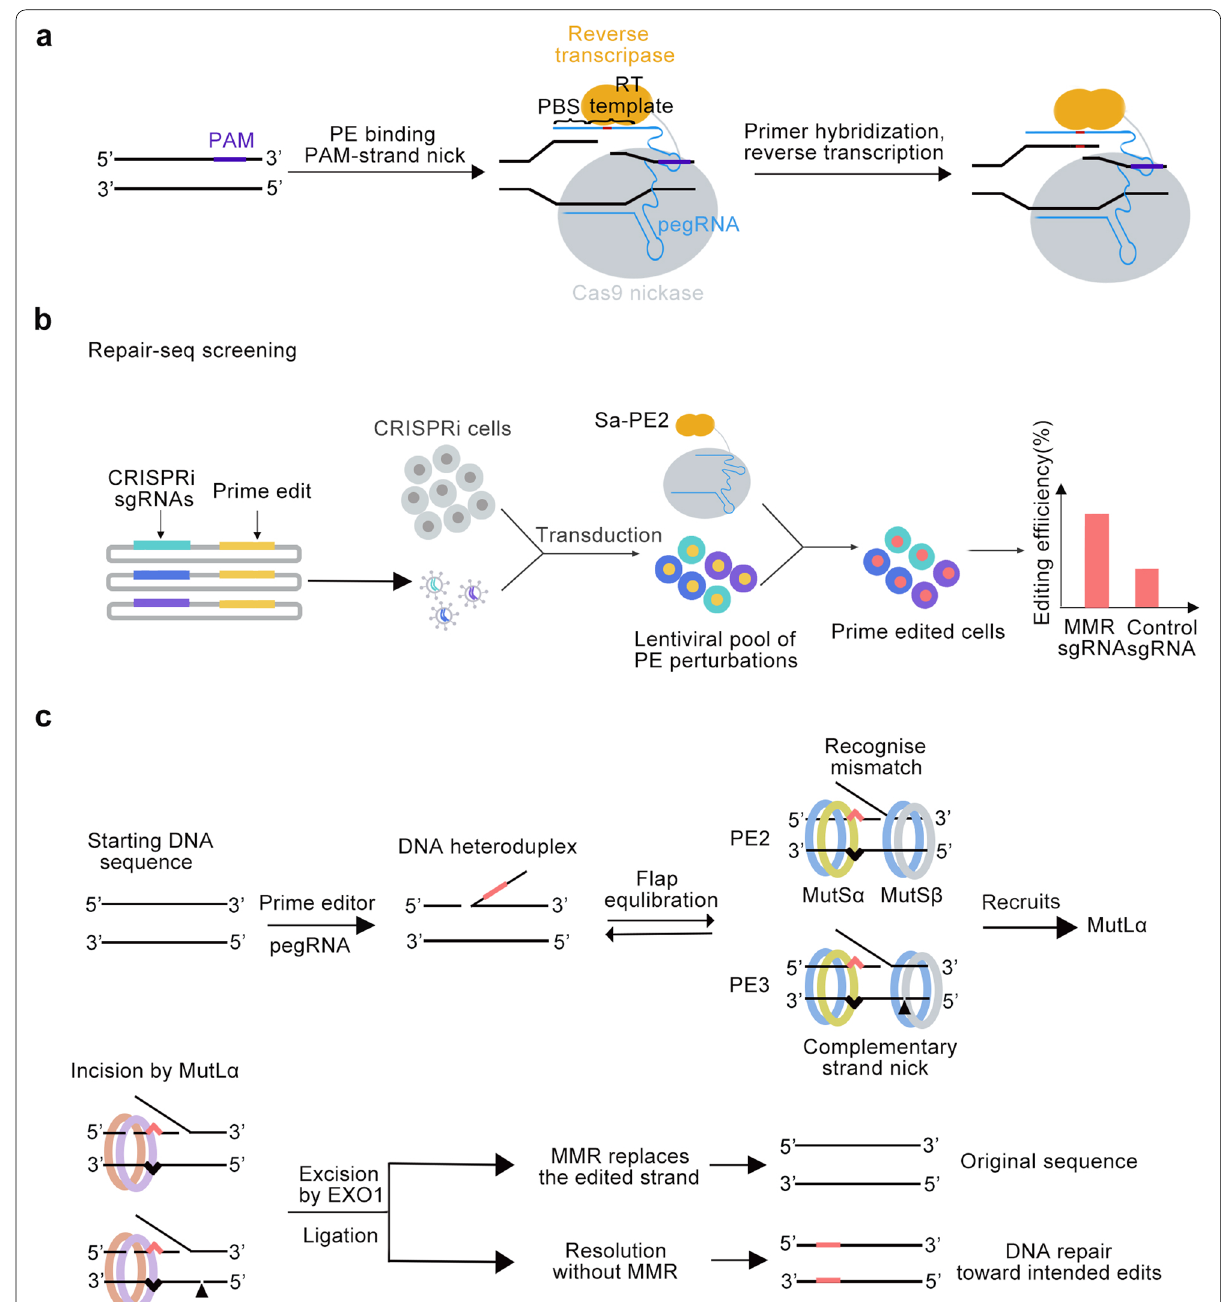
Fig. 1 a Overview of prime editing. b The patterns of MMR Repair-seq screening. c Model for DNA mismatch repair (MMR) of PE intermediates. This figure is completely